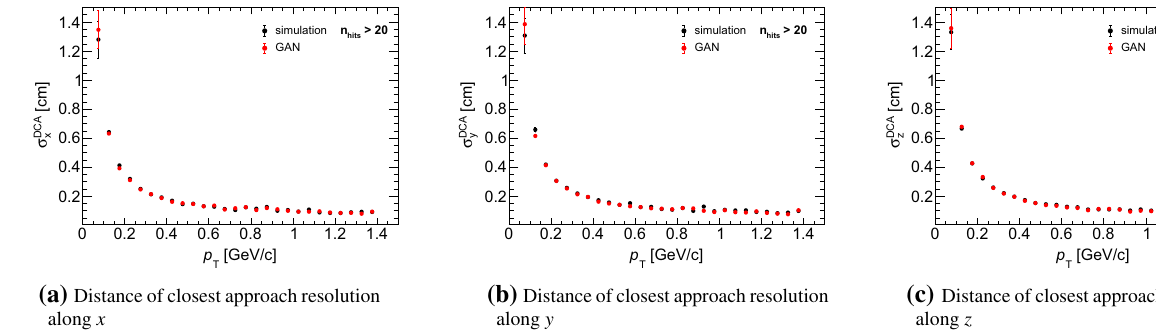
Fig. 4 Distance of closest approach resolution as a function of the transverse momentum